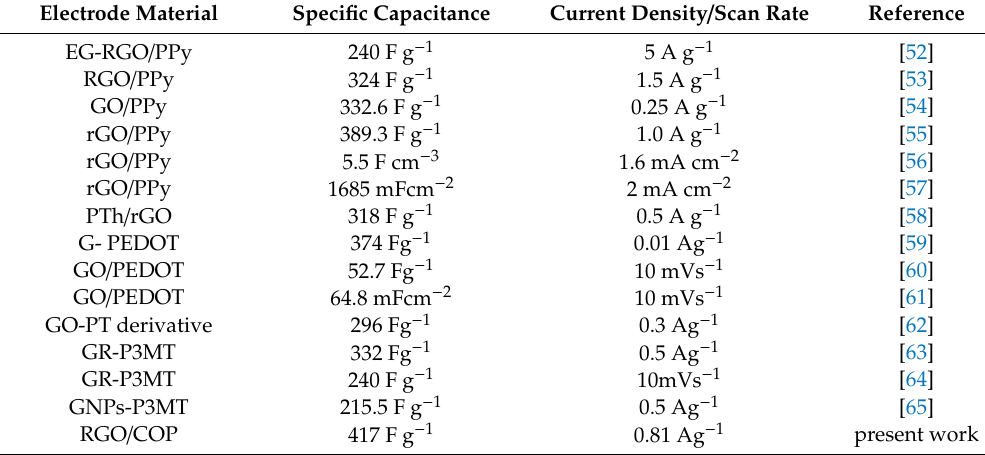
Table 1. Comparison of specific capacitance of some of the PPY / RGO- and PTH / RGO-based nanocomposites with RGO /